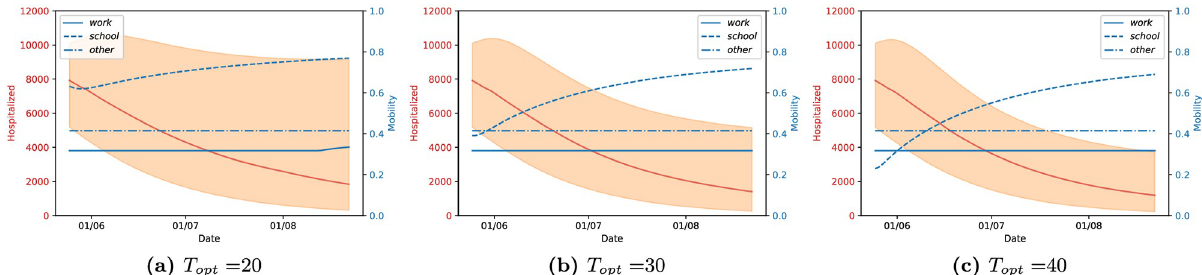
Fig 7. Dependence on the prediction horizon T opt for determining and optimal control strategy for England. Here, ( � s , � w , � o ) = (100, 100, 100) and the lockdown strategies were applied for T = 90 days starting on the 24th of h